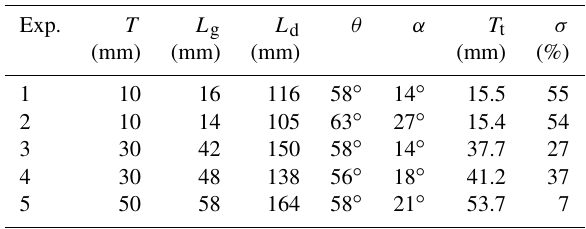
Table 4. Measured ( L g , L d , θ , α ) and imposed ( T ) parameters in the experiments. T : overburden thickness; L d : dome diameter; L g : apical depression width; θ : apical depression fault dip; α : dome flank mean dip; T t : theoretical overburden thickness calculated with Eq. (1) (Brothelande and Merle, 2015; see the Discussion section); σ : percentage difference between T and T t .